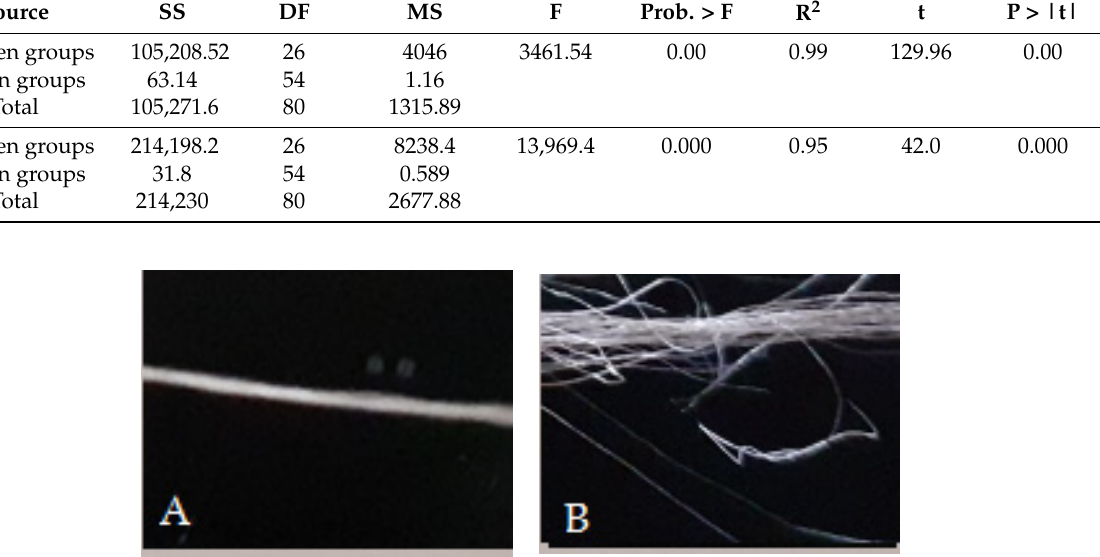
Figure 10. Effects of abrasion on electrical resistance.